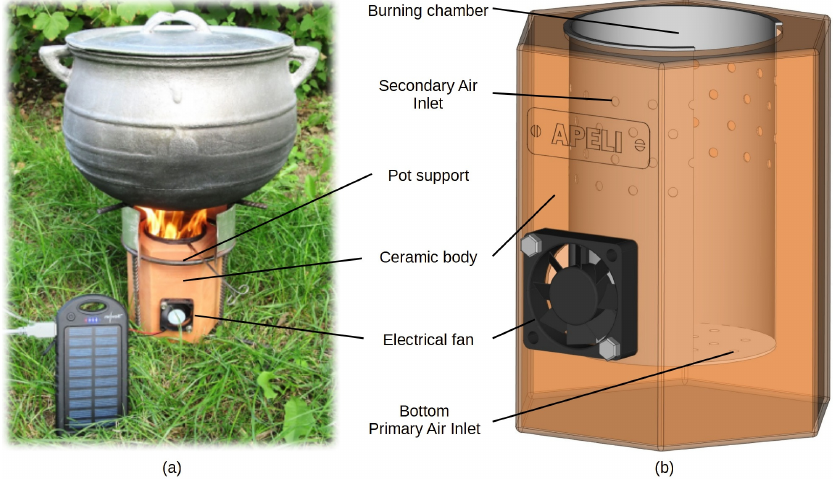
Figure 1. ( a ) Apeli stove developed by DBFZ—operating with solar power bank and typical Togolese No. 3 pot with 7 L volume; ( b ) 3D-scheme of the Apeli burner consisting of ceramic body, combustion chamber and electrical fan (cable not shown in the schematic).